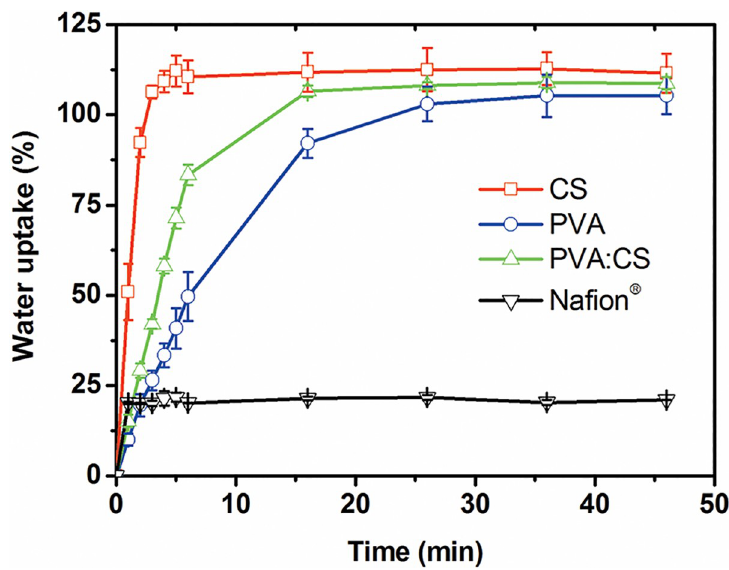
Fig 3. Kinetics of membrane hydration process. Water uptake of CS ( □ ), PVA ( � ), PVA:CS ( Δ ), and Nafion 1 ( 5 ) membranes. Standard deviations are presented at all data points.